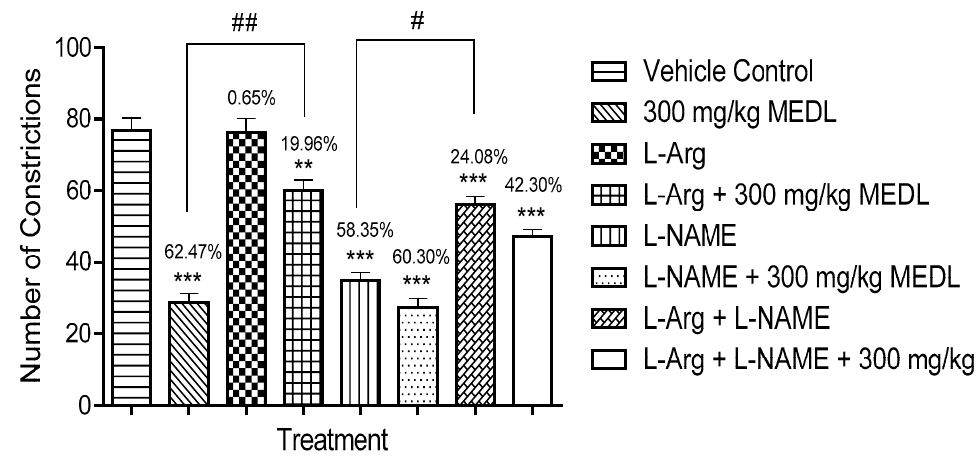
Figure 8. E ff ects of l -arg or l -NAME on MEDL against acetic acid-induced abdominal constriction test in mice. Each column represents the mean ± SEM of six mice. Statistical analyses were performed using 1-way ANOVA followed by Tukey’s multiple comparisons test. ** p ≤ 0.01 and *** p ≤ 0.001 compared to vehicle control group; # p < 0.05 and ## p < 0.01 compared to 300 mg / kg MEDL or l -NAME-treated group. Values on top of each column denote inhibition.